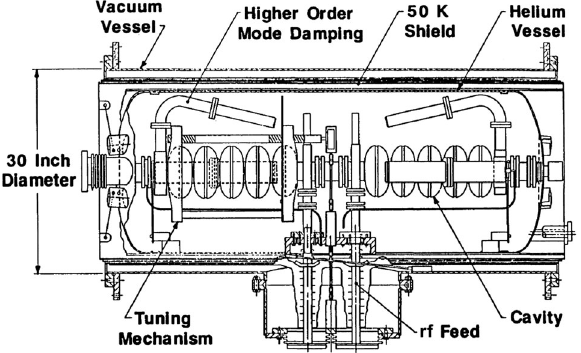
FIG. 2. Schematic of one-quarter section of an original CEBAF cryomodule, with a cavity pair inside the He vessel (from Ref. [9]).